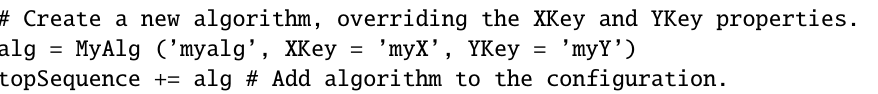
Figure 1. General structure of an Athena